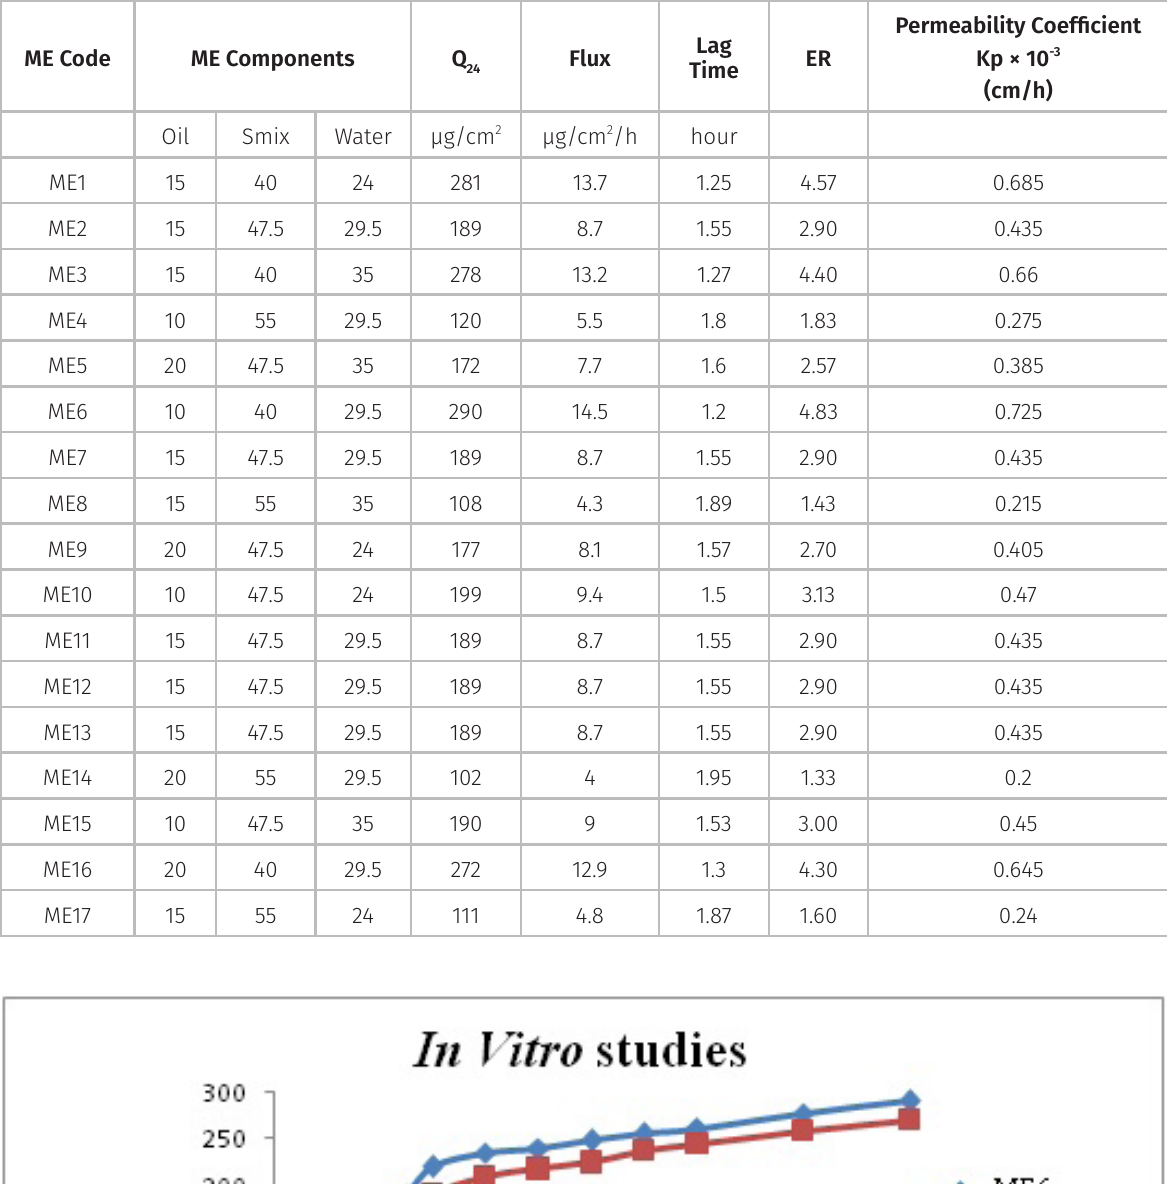
Table III. Variables and observed responses in Box Behnken Design for microemulsions.